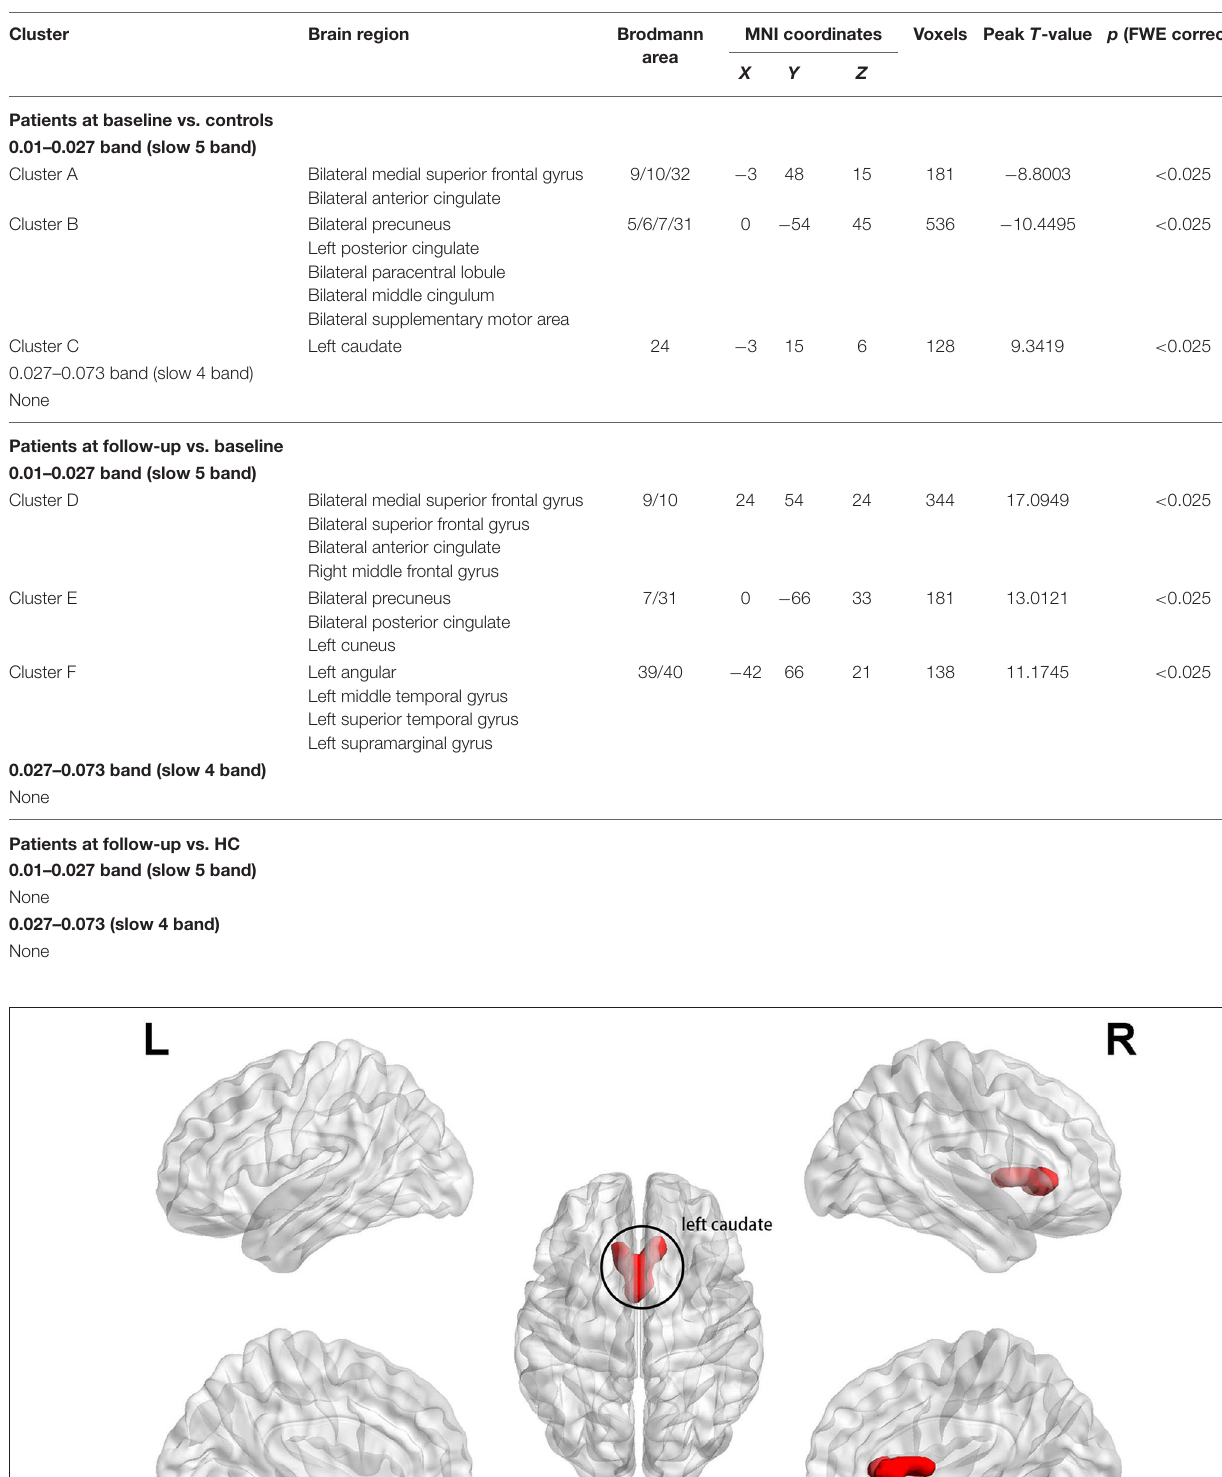
MNI coordinates Voxels Peak T -value p (FWE corrected) area X Y Z